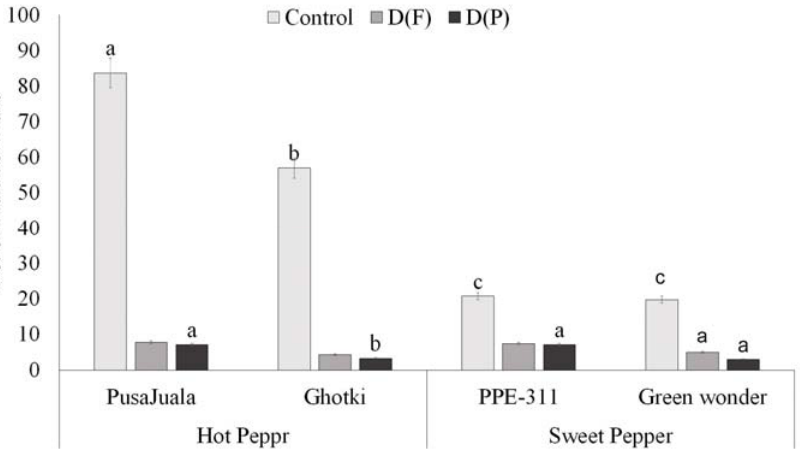
Figure 4. The number of fruits per plant. Means of three repetitions for each genotype with the same letters indicate the same means, and different letters indicate significant differences. Vertical bars represent standard error of means (bars = ±se) (LSD p < 0.05). DF = water stress at the flowering stage, DP = water stress at the pod formation stage.